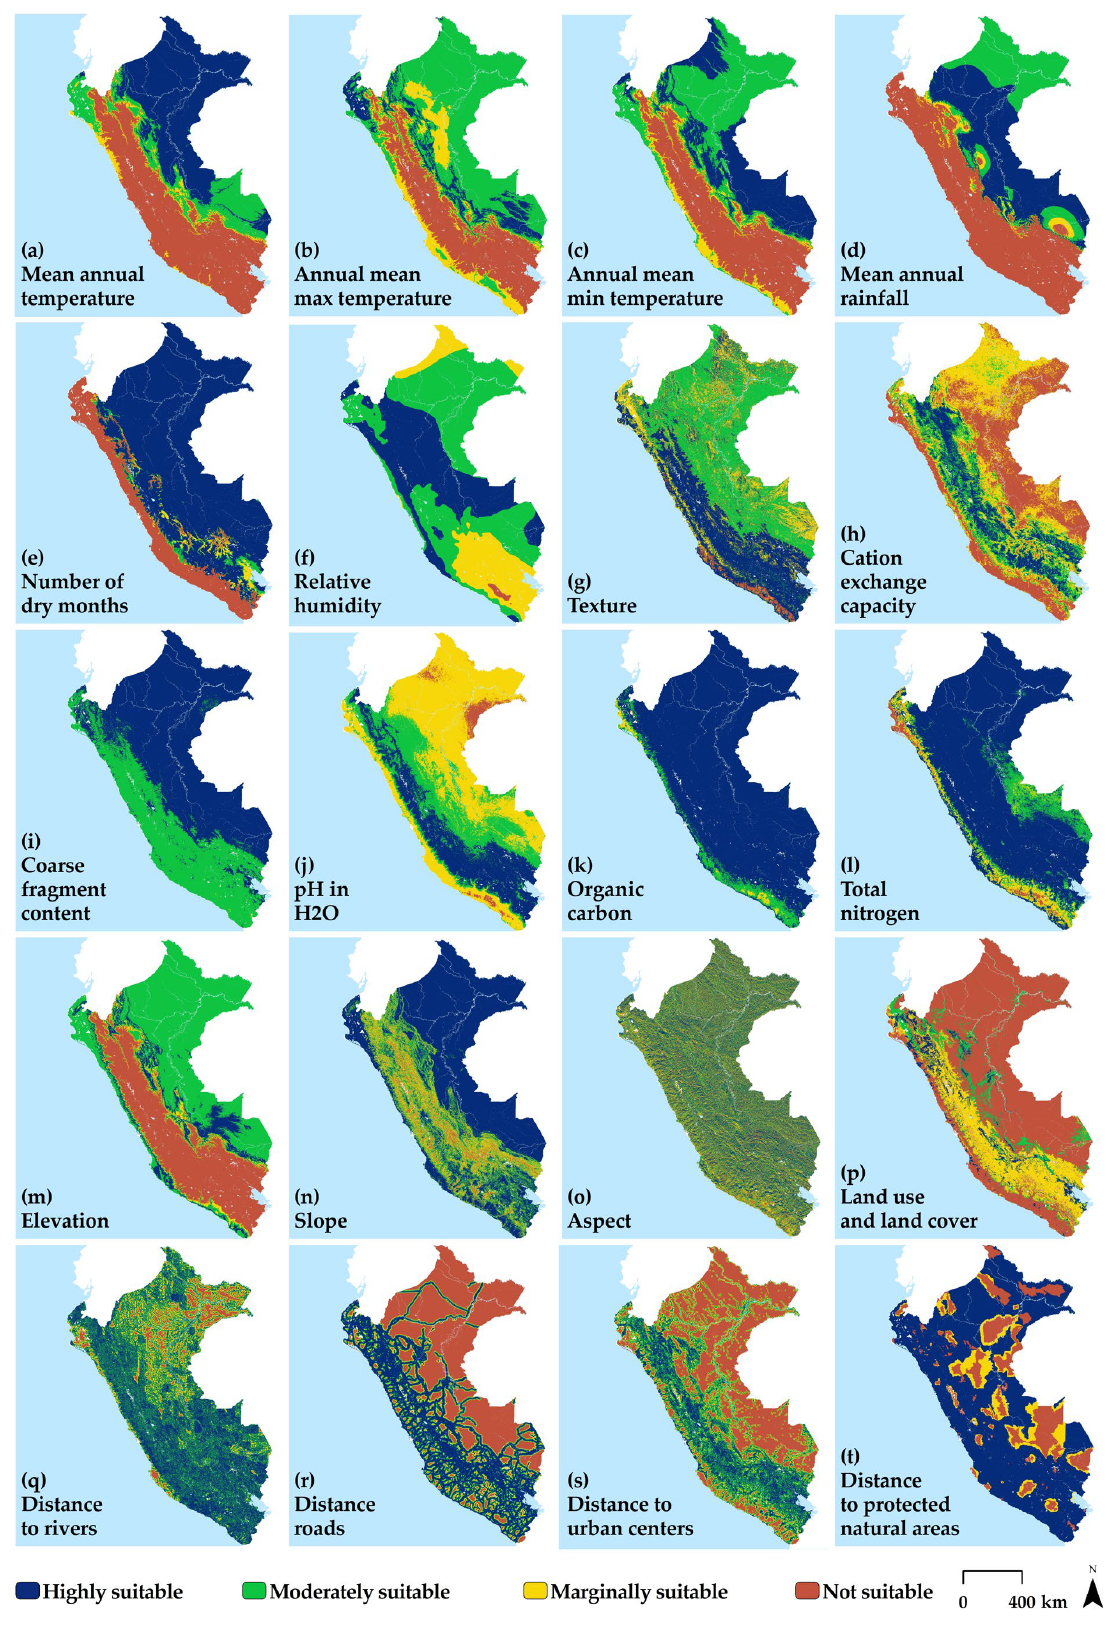
Figure 3. Suitability maps of the climatological ( a – f ), edaphological ( g – l ), orographic ( m – o ) and socioeconomic ( p – t ) subcriteria for cocoa cultivation in Peru.